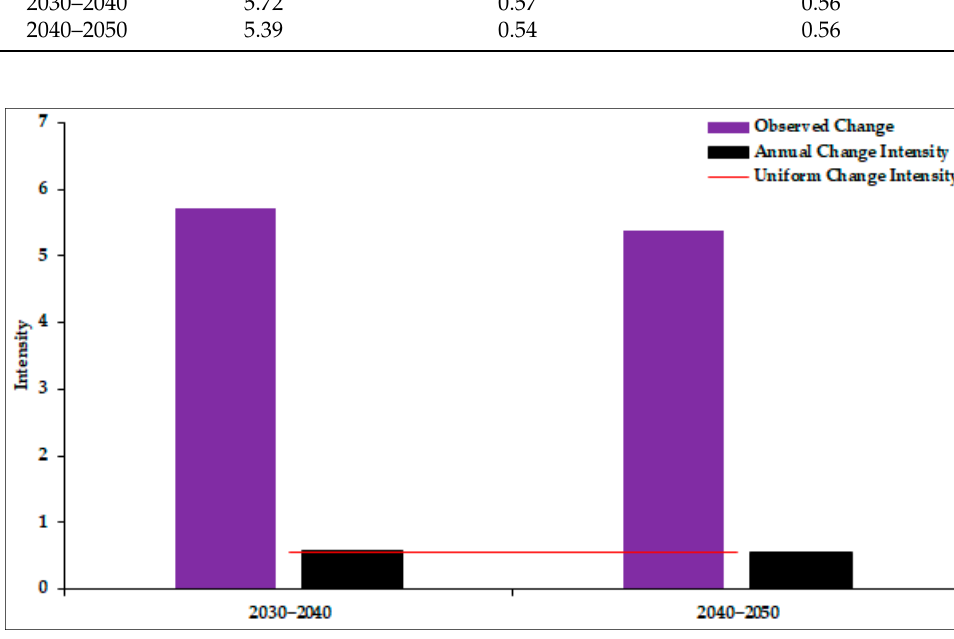
Table 24. Interval-level Change Intensity (2030–2050).